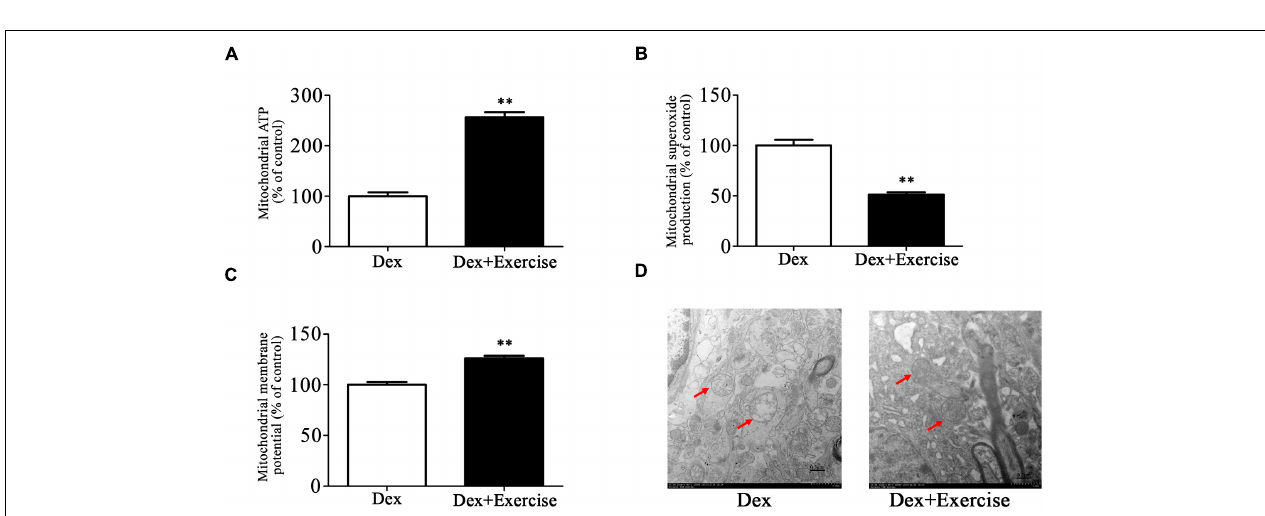
FIGURE 5 | Effects of treadmill exercise on depression-like behaviors and circulatory corticosterone level in Dex offspring. Dex offspring at 4-week old received 4 weeks of treadmill exercise. Then, sucrose preference test (A) and FST (B) , and corticosterone concentration in blood (C) were determined. Data are presented as means ± SEM ( n = 6/group). ∗∗ P < 0.01 vs. Dex. Dex, dexamethasone; CORT, corticosterone.